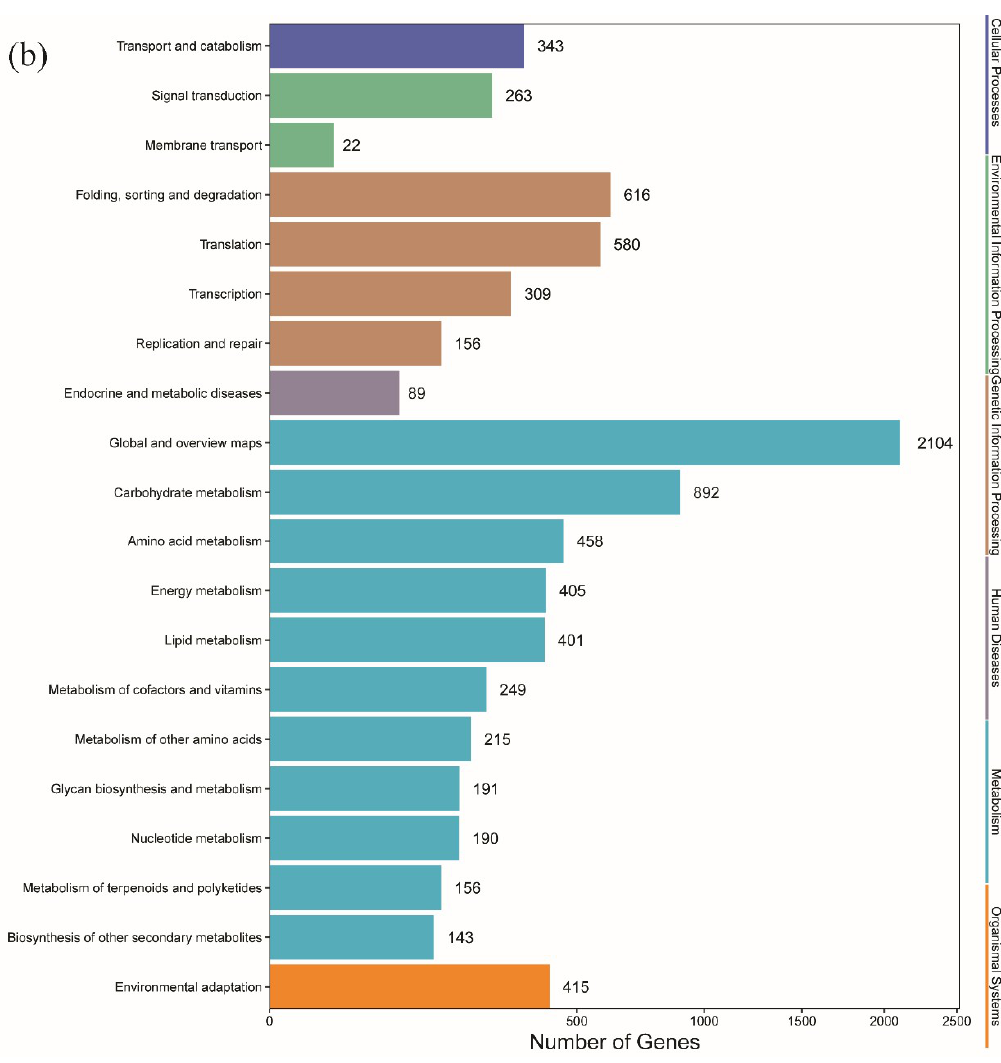
Figure 5. Functional annotation and classification of unigenes associated with AS events in S. baicalensis . ( a ) Gene Ontology (GO) enrichment; ( b ) Kyoto Encyclopedia of Genes and Genomes (KEGG) enrichment.